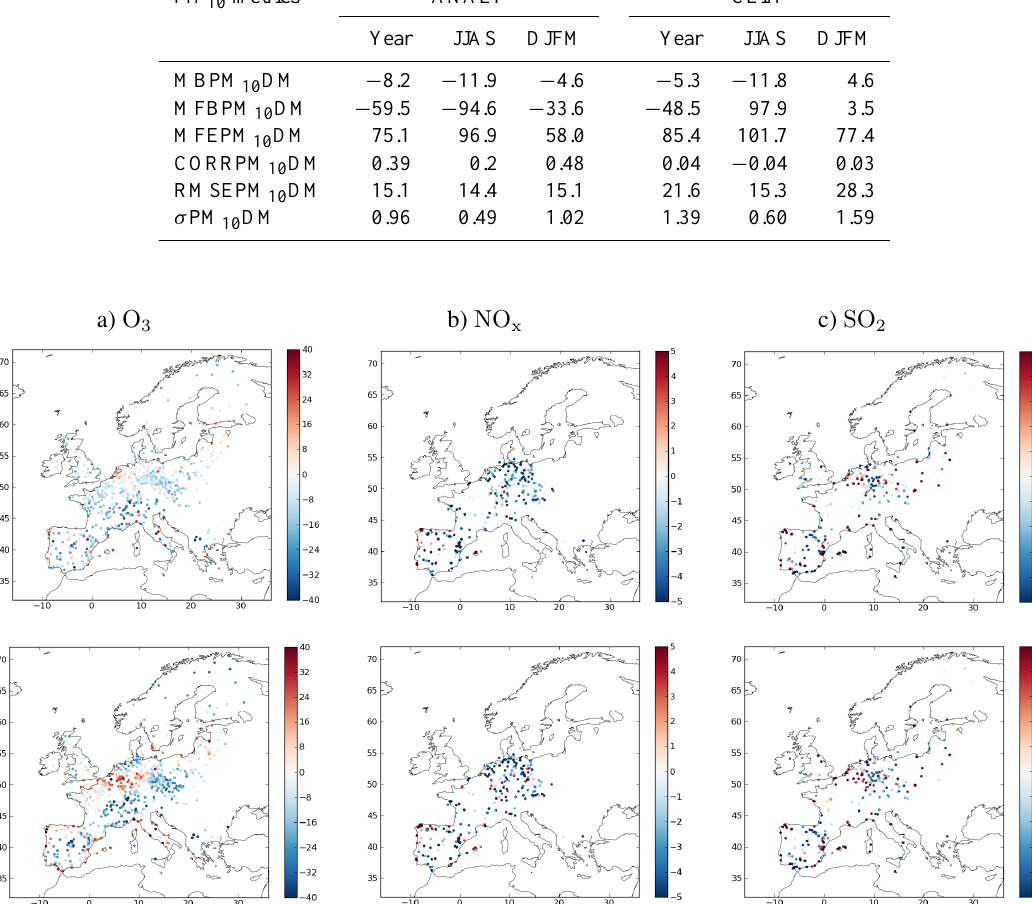
(a) , daily mean NO (b) and 3 x